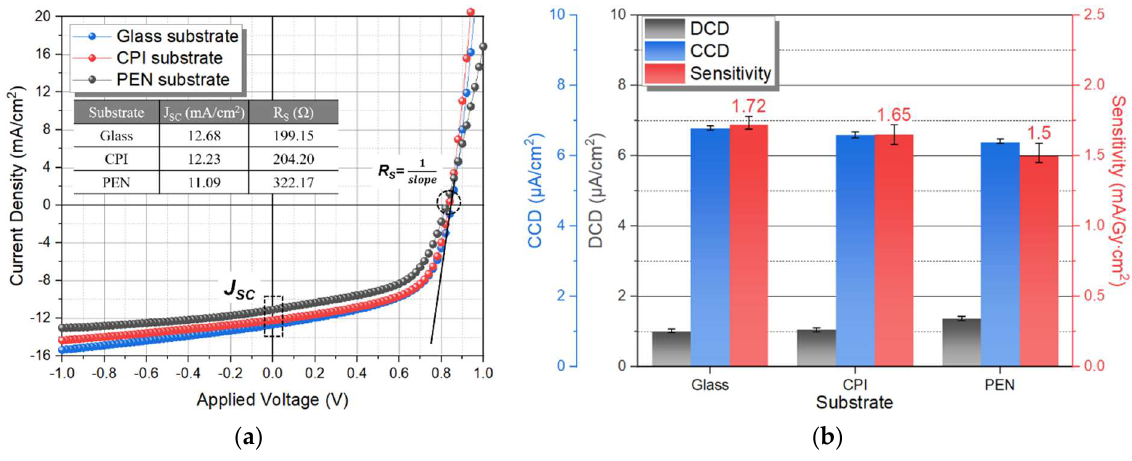
Figure 5. ( a ) J–V characteristics of photodetector with the PBDB-T:PC 71 BM active layer, and ( b ) CCD, DCD, and sensitivity of the X-ray detector on glass, CPI, and PEN